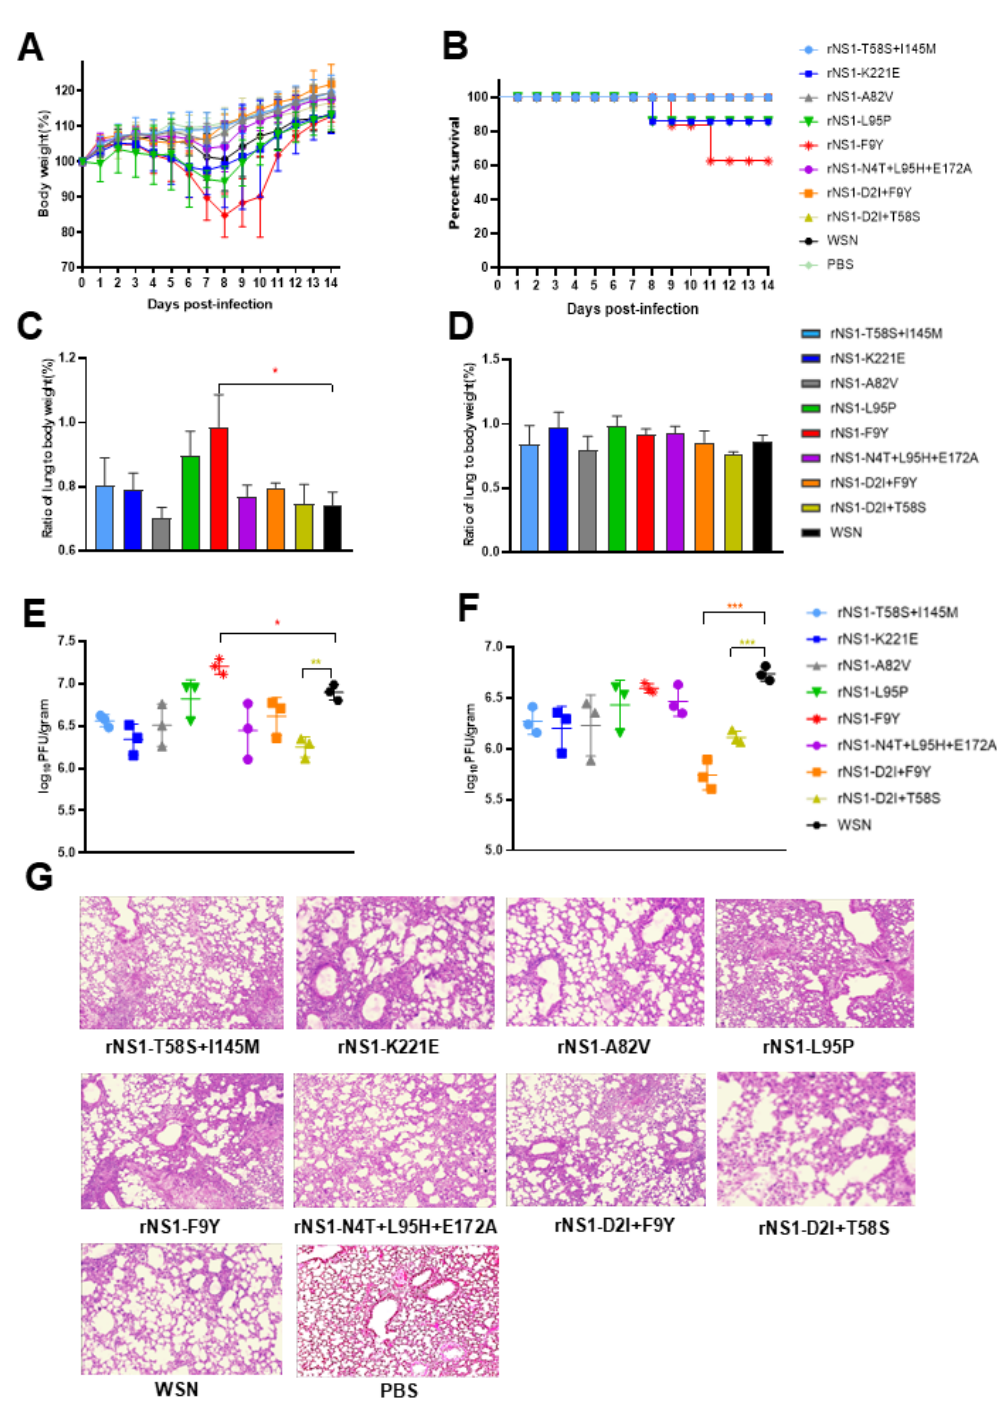
Figure 3. Replication and pathogenicity of NS1 mutants in mice. ( A ) Body weight changes of mice infected with 5 × 10 3 PFU of rNS1 mutants and WSN viruses. ( B ) Survival curves of mice infected with 5 × 10 3 PFU of rNS1 mutants and WSN viruses. Mice were euthanized and scored dead when the mice lost 25% of their baseline body weight (measured on the day of infection). ( C ) Ratio of lung to body weight of rNS1 mutants and WSN viruses at 3 dpi. BALB/c mice inoculated with 10 4 PFU of rNS1 mutants and WSN viruses, the ratios of lung to body weight were calculated. ( D ) Ratio of lung to body weight of rNS1 mutants and WSN viruses at 5 dpi. ( E ) Viral replication titers of the infected mice lungs at 3 and ( F ) 5 dpi. ( G ) Pathological analysis of mice lungs infected with rNS1 mutants and WSN viruses at 3 dpi. p values were calculated by using the Student’s t -test, * p < 0.05, ** p < 0.01, *** p <